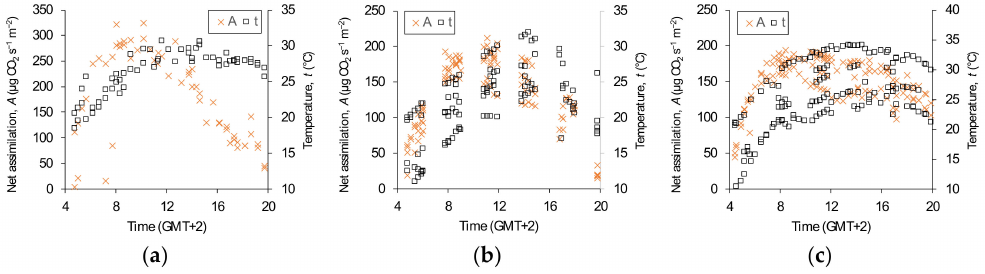
Figure A1. Daytime values of the shoot net photosynthetic assimilation A under full sunlight during the measurement campaigns (crosses, left axis) and the corresponding shoot chamber temperature (right axis, squares) for ( a ) 2014; ( b ) 2015 (flattened shoot); and ( c ) 2015 (undeformed shoot).